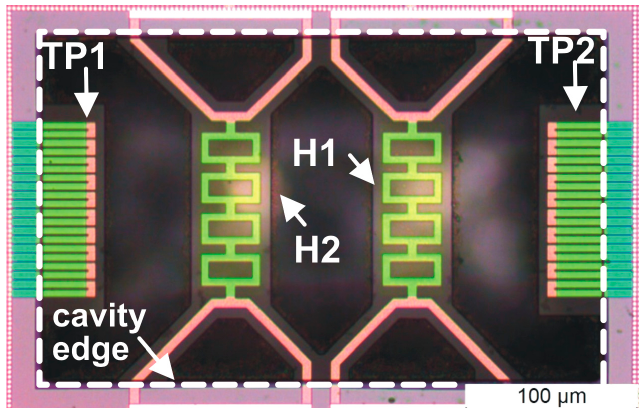
Figure 4. Optical micrograph of the sensing structure at the end of the micromachining procedure.